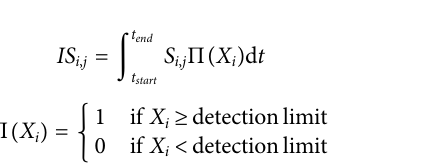
Frontiers in Mechanical Engineering |